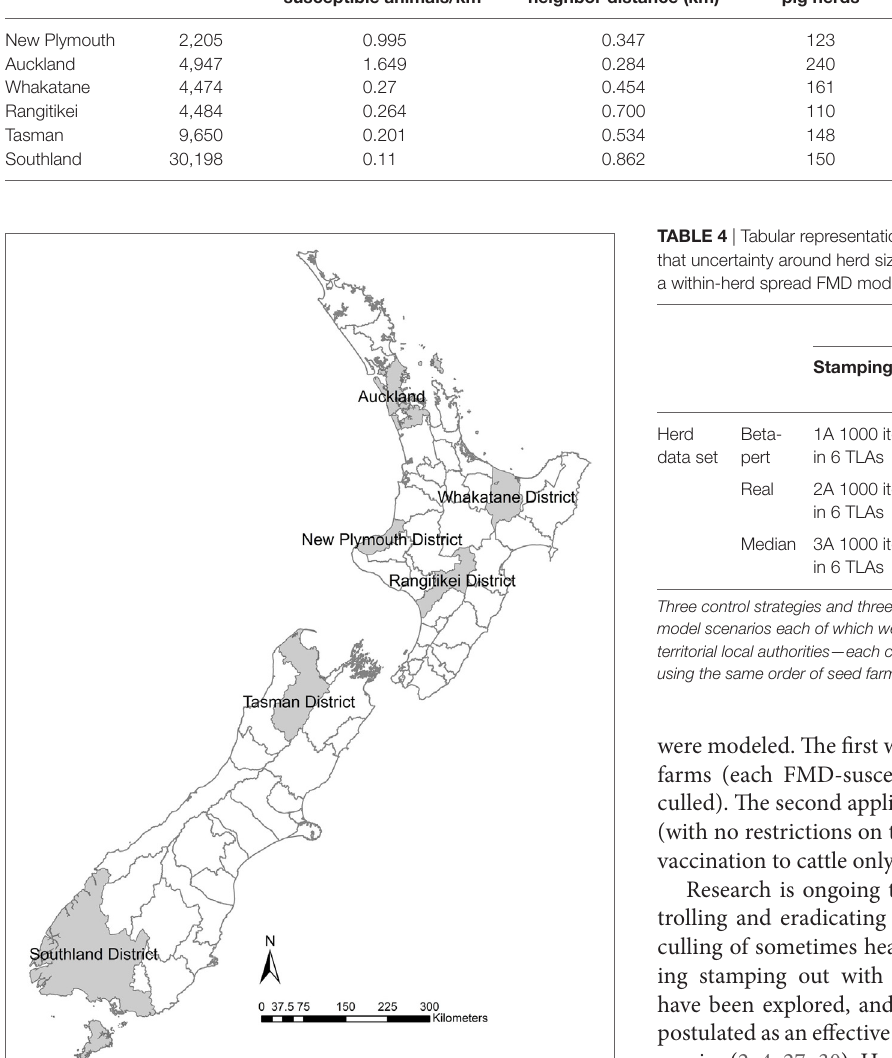
Table 3 | Description of the six New Zealand territorial local authorities (TLAs) used as disease index herd for hypothetical foot-and-mouth (FMD) outbreaks in the study.